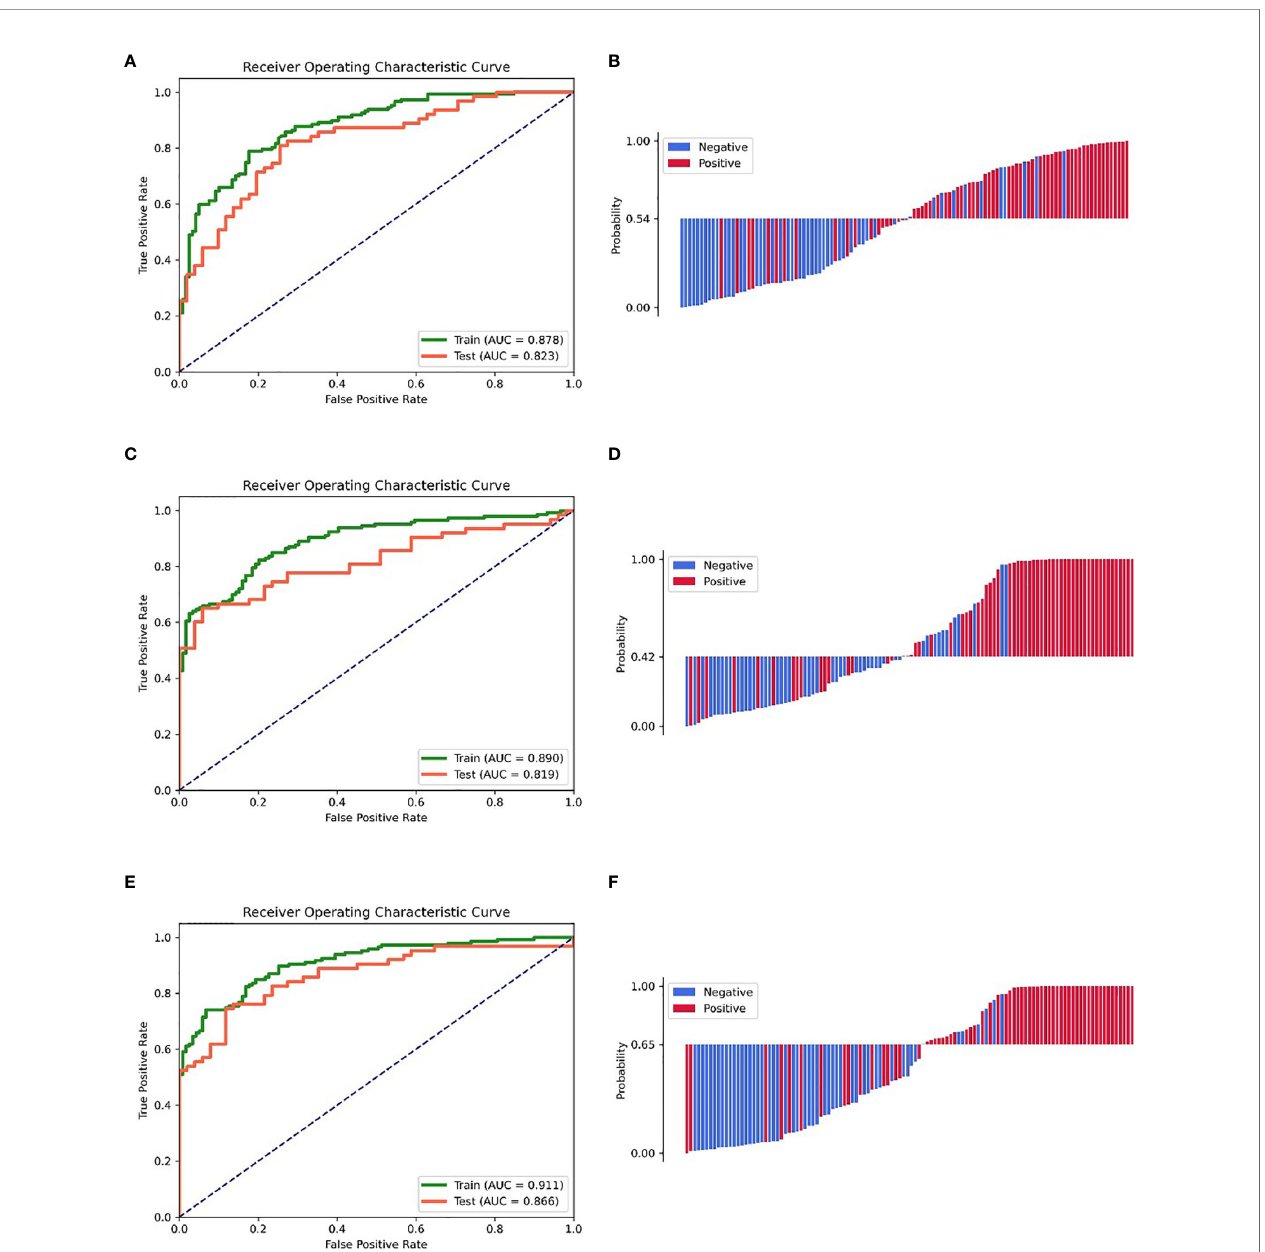
FIGURE 3 | ROC curves of the training and testing cohorts, the waterfall plot of the distribution of prediction probability on the testing cohort. (A, B) Clinic-radiological model. (C, D) Radiomic signature. (E, F) Combined model.